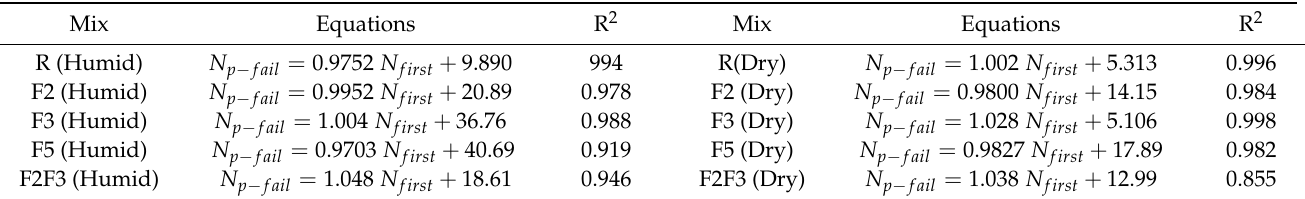
Table 11. The estimation equations formulated for fracture strength.